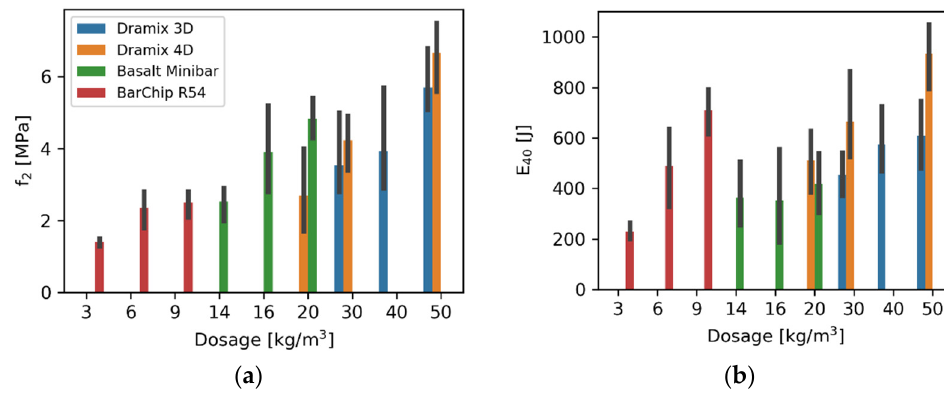
Figure 6. Residual flexural strength at 2 mm vertical deflection ( a ) and energy absorption at 40 mm deflection ( b ) for different fibre types and dosages. Vertical lines indicate distribution in data.